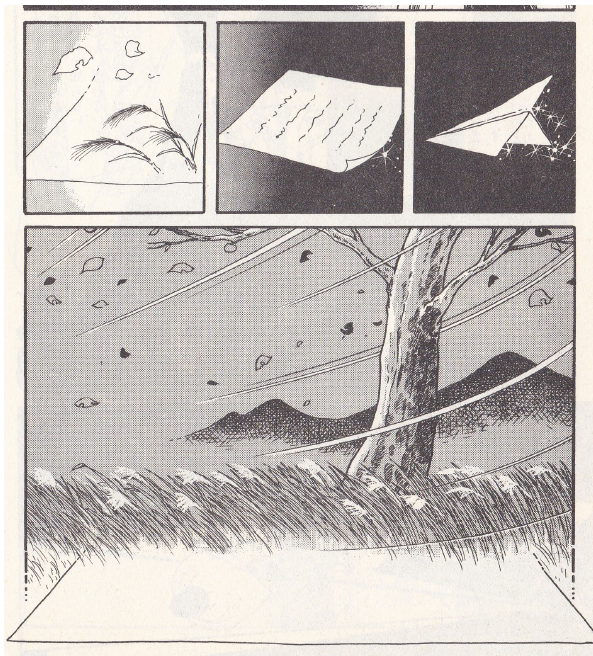
Figure 12. A letter sent by the woman describes the moonlit night (Kosakabe and Tanaka, Manga Izumi Shikibu nikki , 1990), 182. Courtesy of